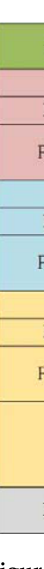
Figure 9. Output frame structure sent to the serial port. Table 1. Radar Configuration.